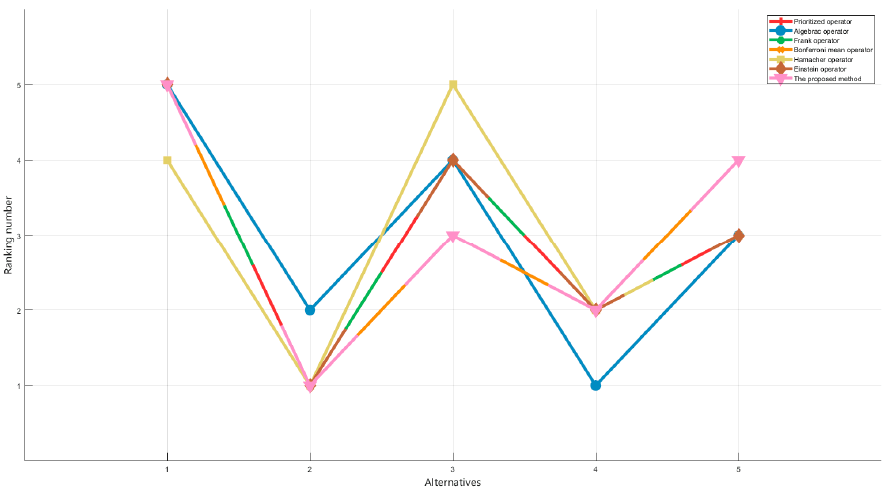
Figure 7. Comparison